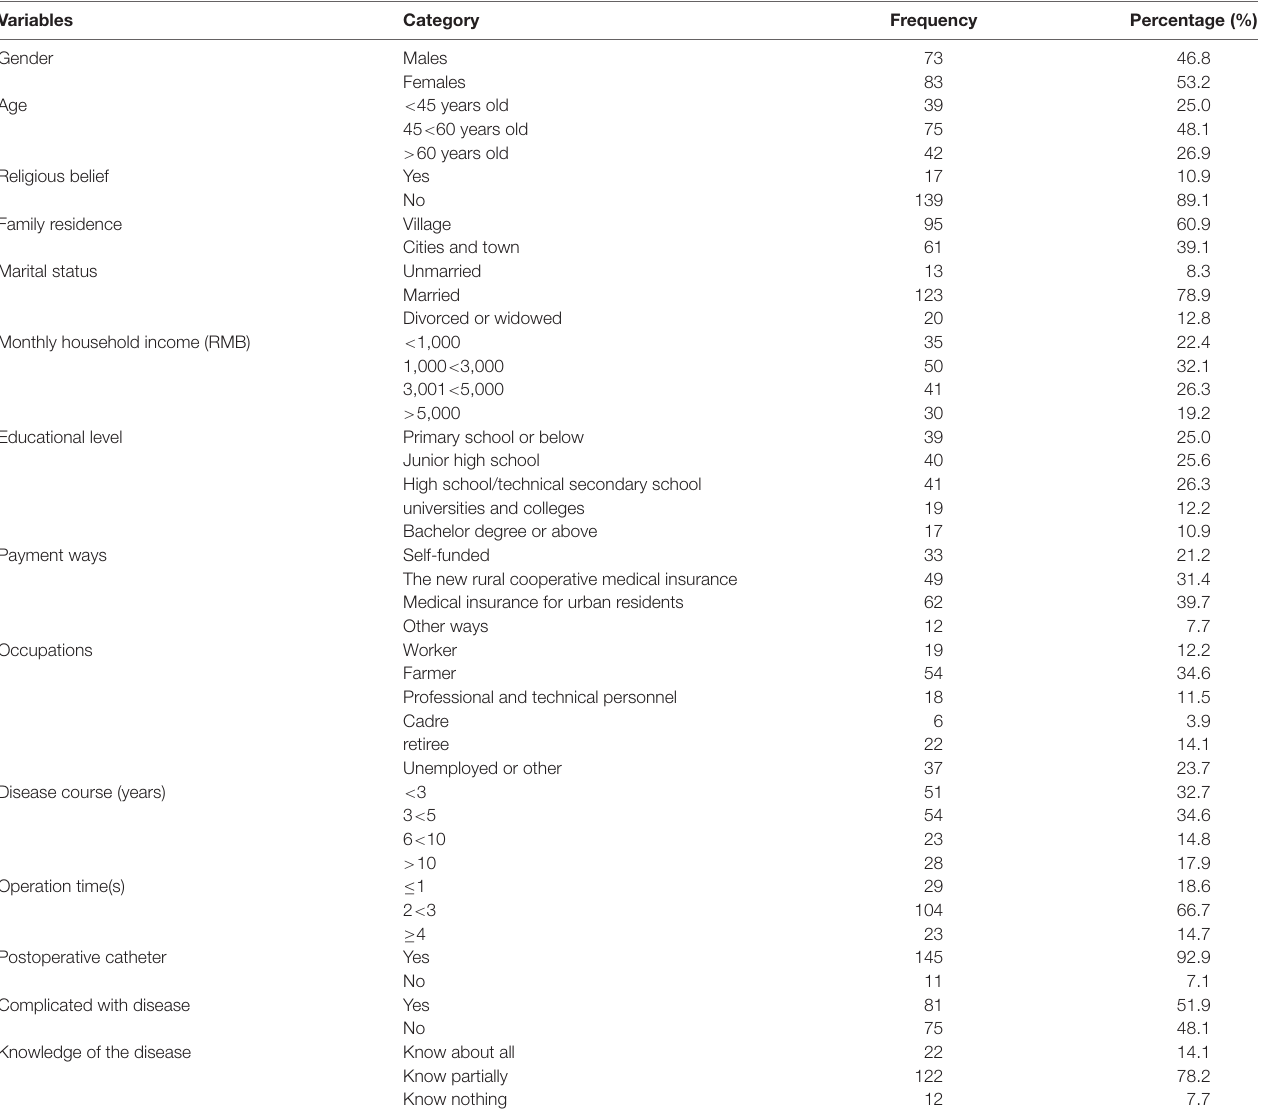
TABLE 1 | General information of research objects ( n = 156, %).